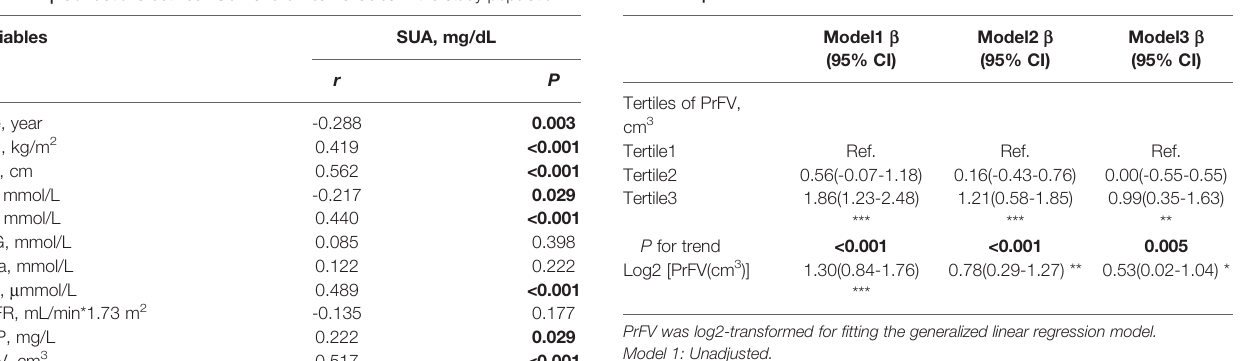
TABLE 3 | The association between PrFV and SUA.